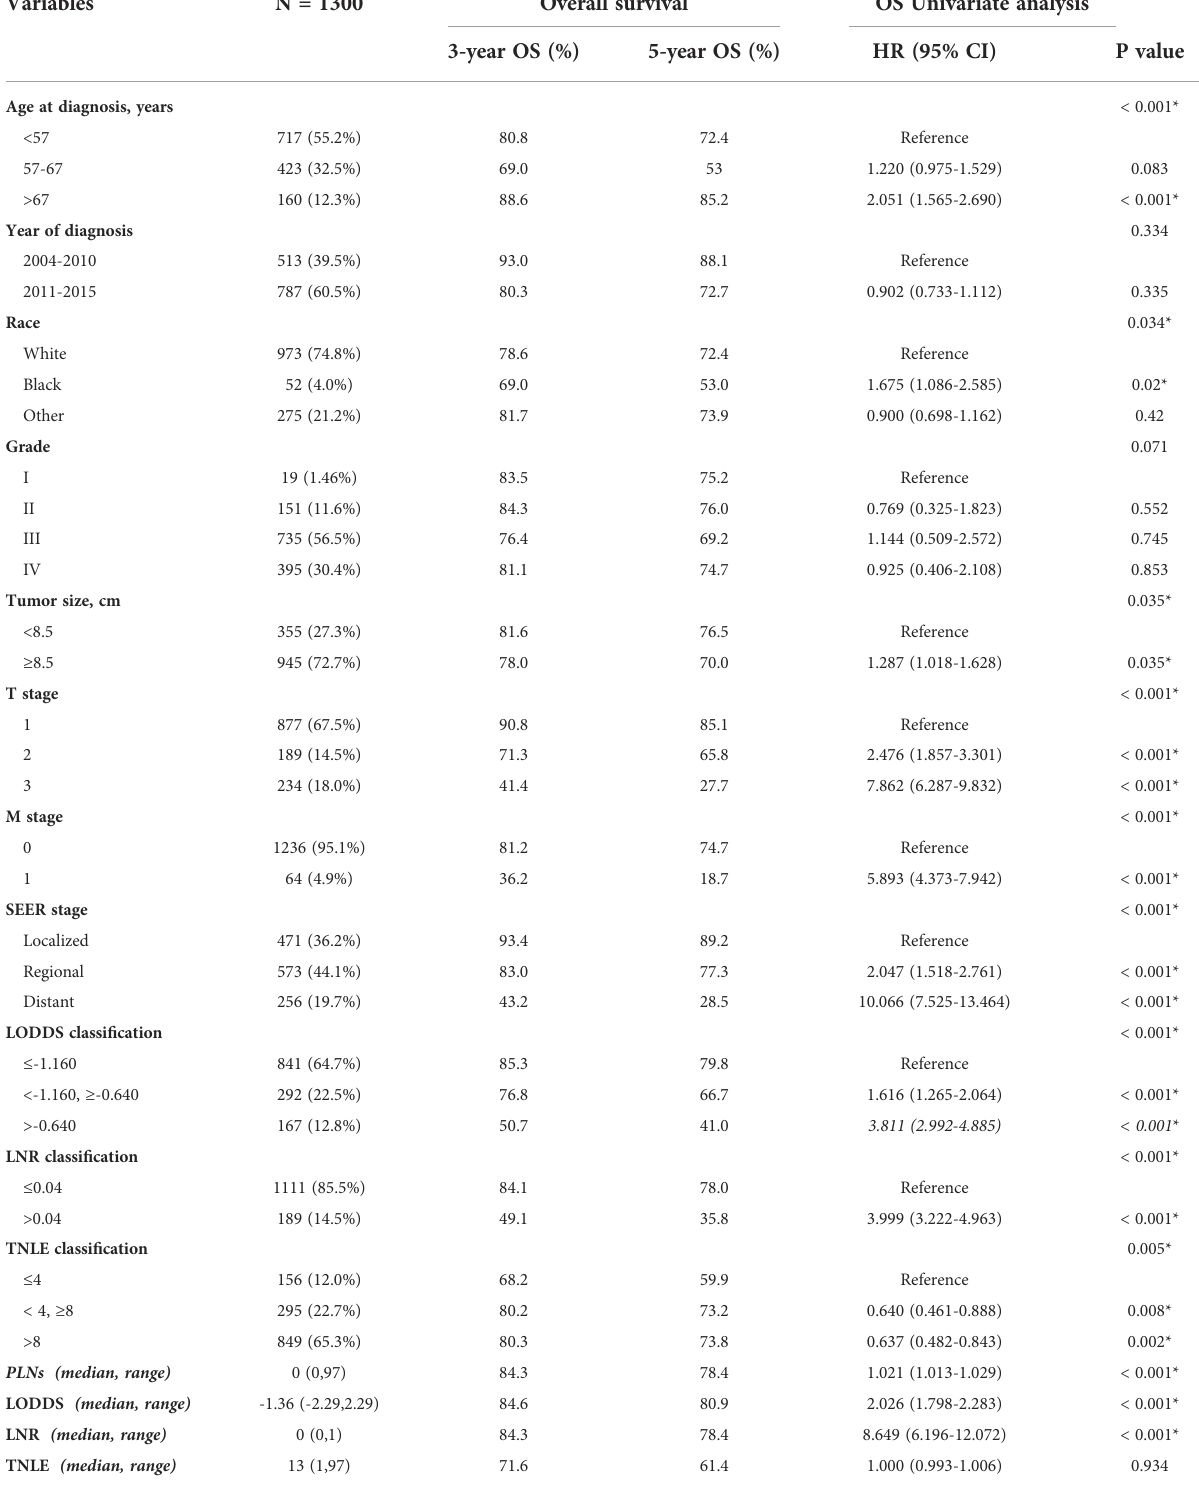
TABLE 1 Clinical characteristics in prognostic results and univariate cox analysis for